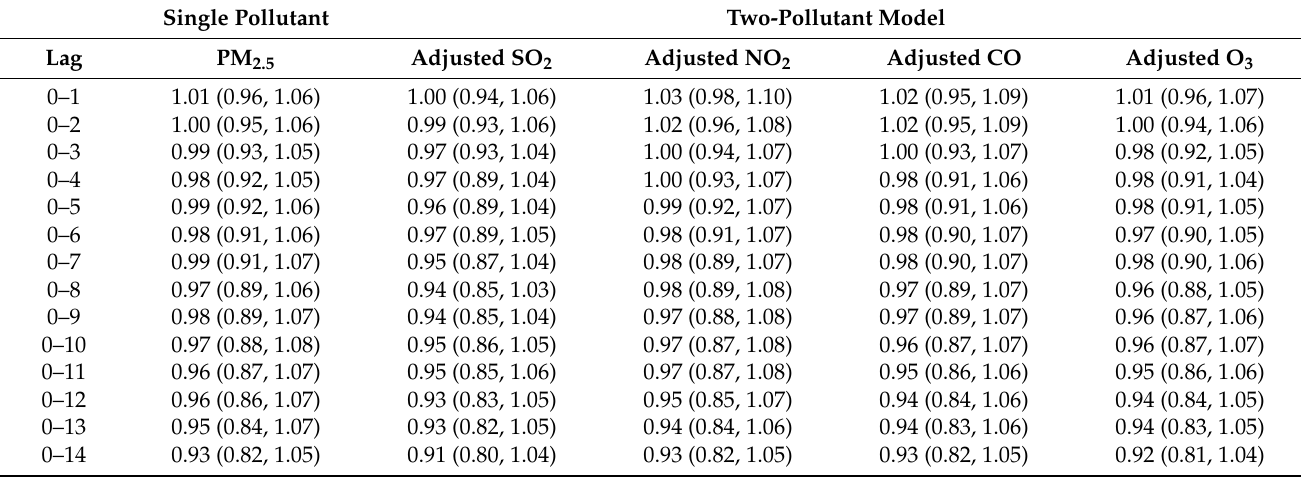
Table 4. The association between short-term exposure to PM 2.5 and children’s KD hospitalization in the two-pollutant models. Single Pollutant Two-Pollutant